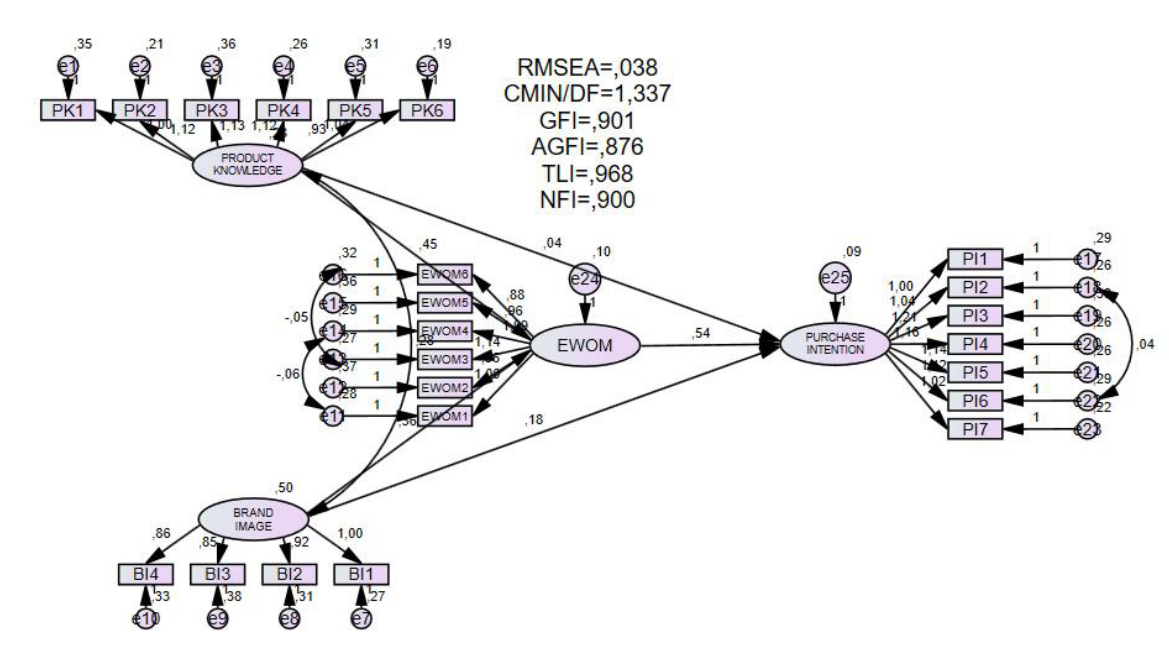
Figure 2: Research Results Fit Model